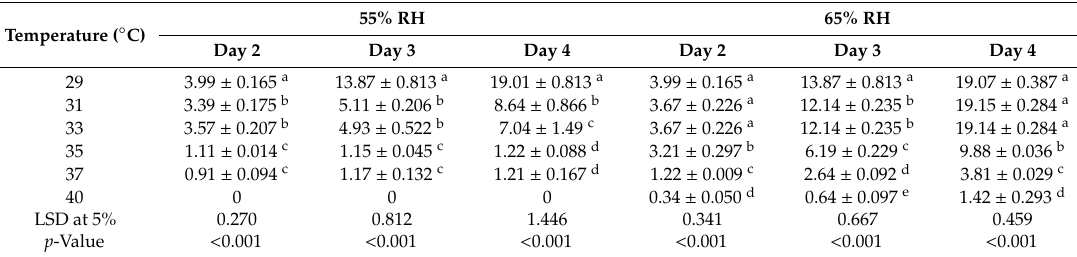
Table 3. Mean pollen tube growth (mm) ± SD ( n = 3) through the pistil of the coconut variety WCT under in vitro temperature treatments. The fresh receptive flowers collected were artificially pollinated and incubated at di ff erent temperatures and two humidity levels. Samples under di ff erent treatments were collected daily for histological